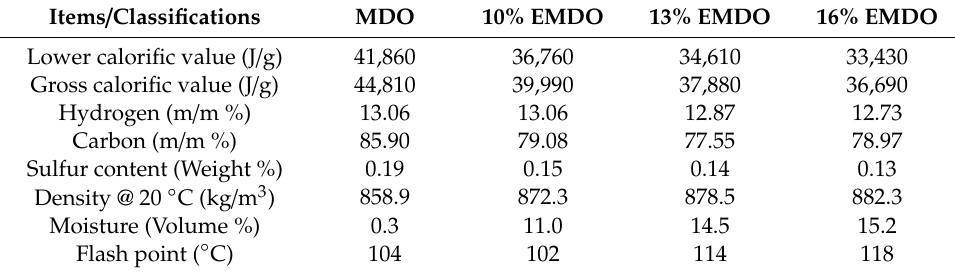
Table 4. Emulsified oil fuel properties used in the marine